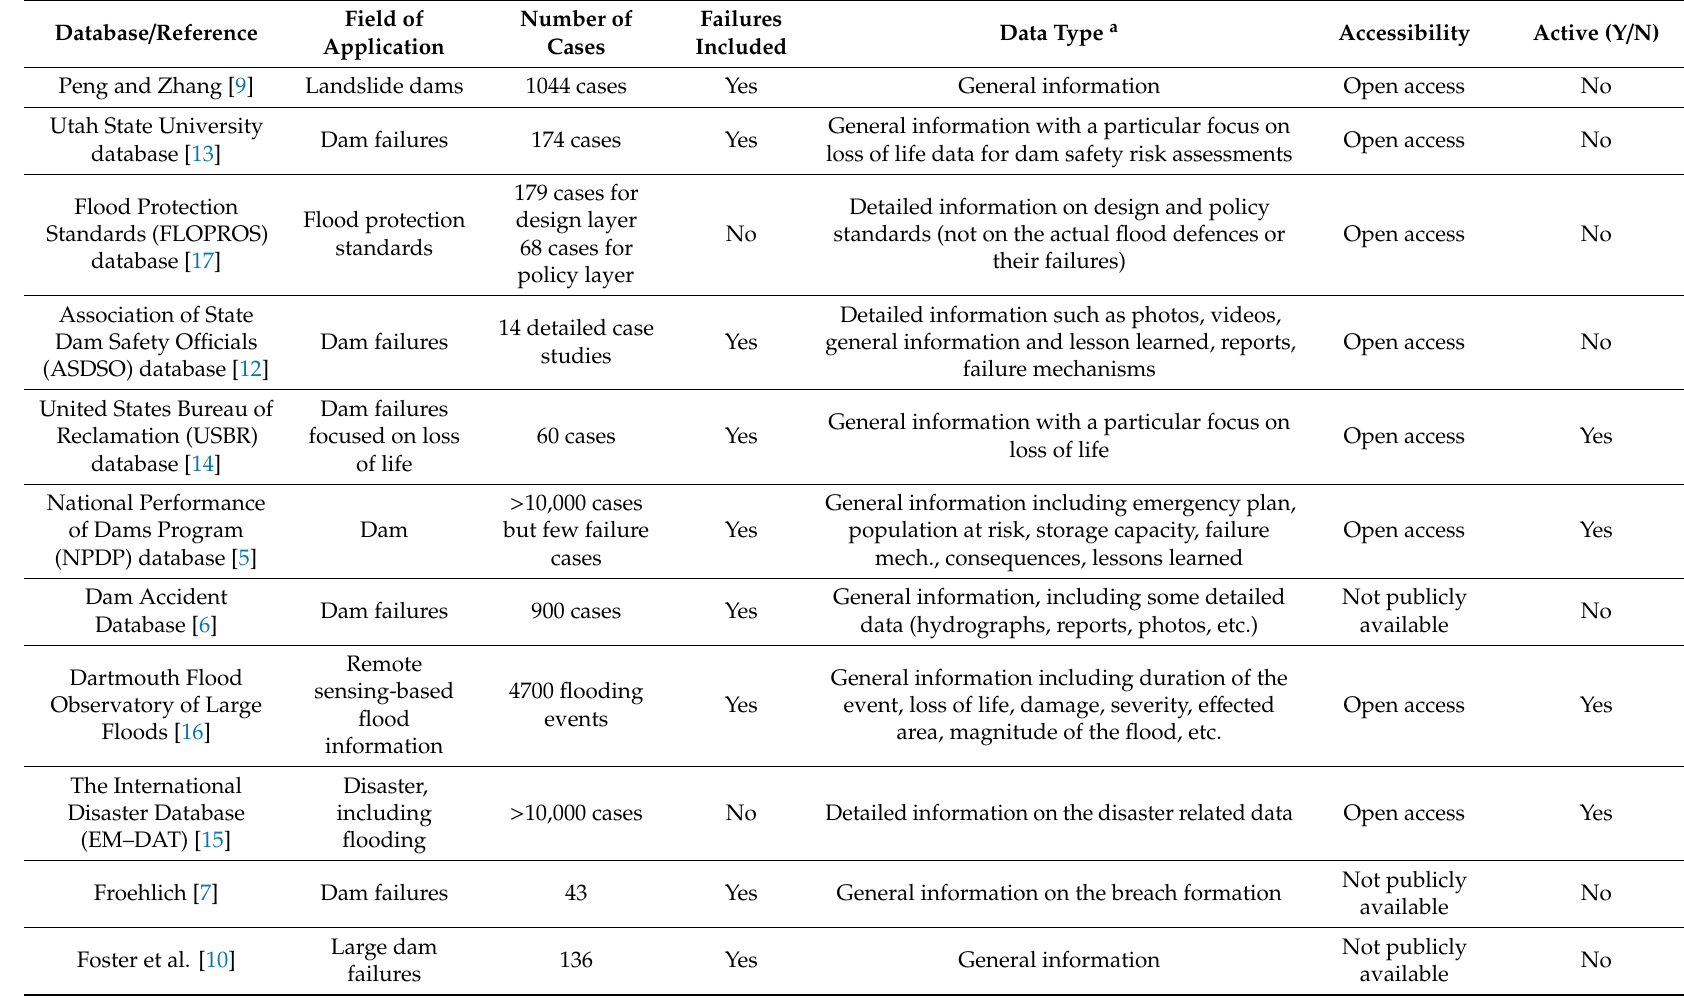
Table 1. An overview of the example databases in the field of flood risk, dam and levee